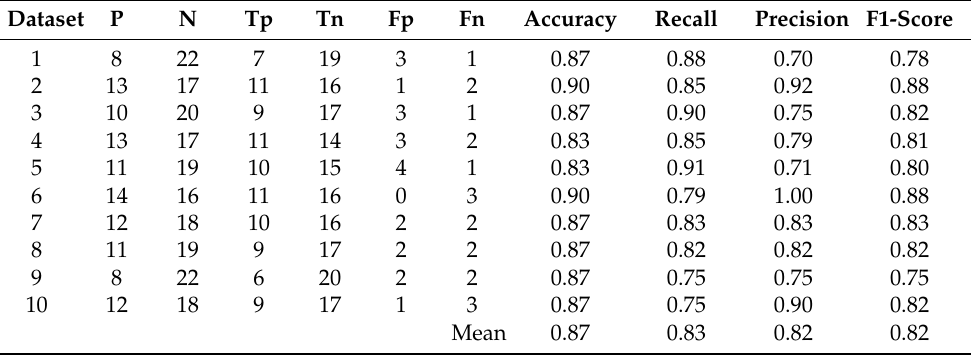
Table 3. D.T. models trained and tested on ten randomly selected datasets.